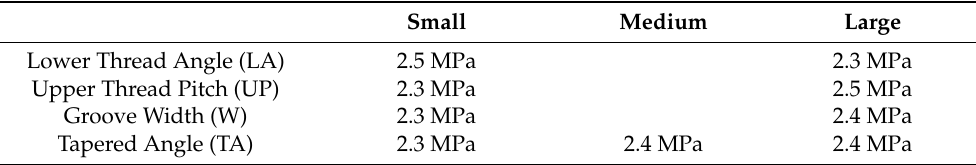
Table 6. Comparison of average stress on the first layer of test block of four different design factors in 20 PCF.